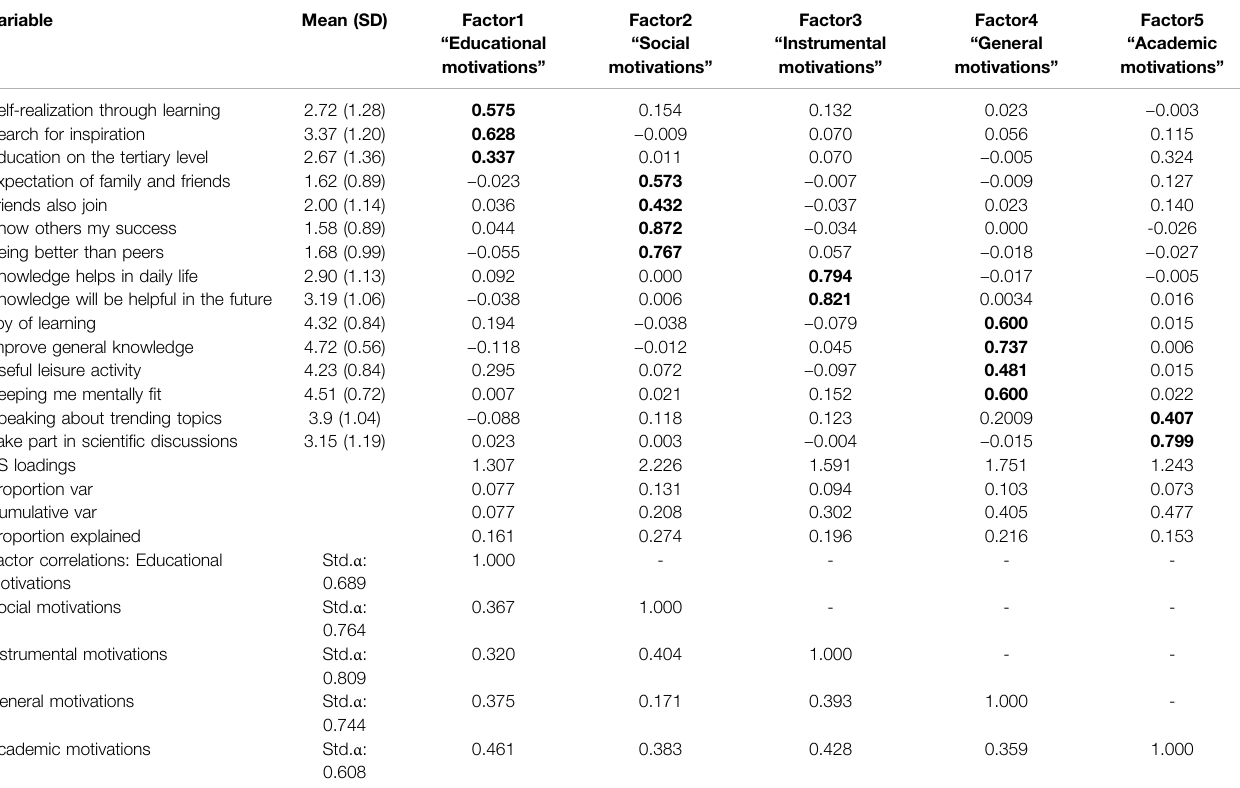
TABLE 2 | Factor analysis